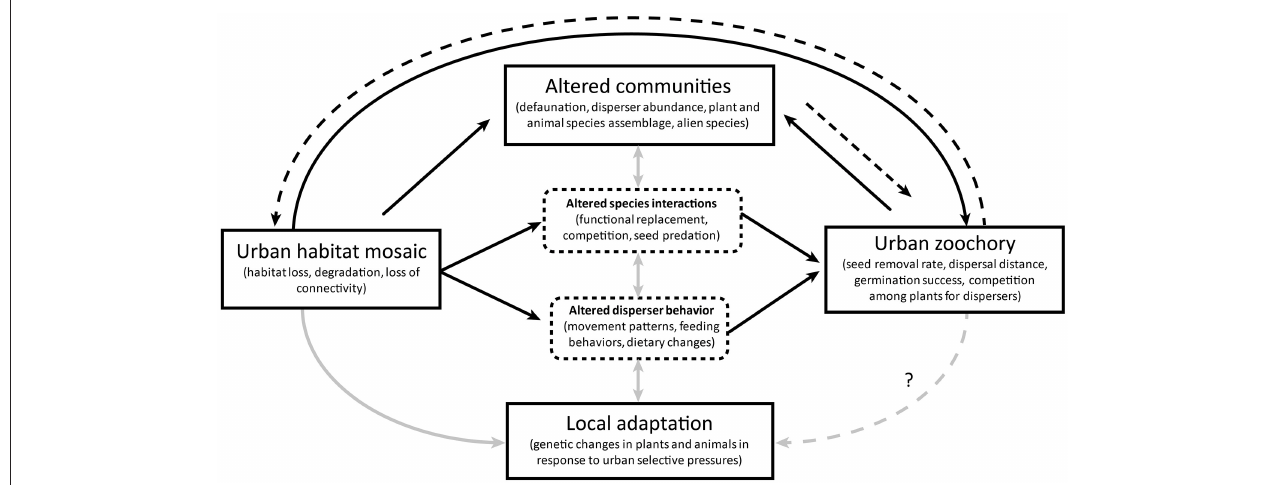
FIGURE 1 | Interdependence between zoochory processes and the urban ecosystems. The urban effects of an altered habitat on zoochory may be direct (e.g., by influencing the abundance of dispersers or their success) or mediated through changes in seed disperser behaviors and novel species interactions (black continuous lines). In turn, seed dispersers shape urban vegetation within the mosaic, strengthening or weakening the processes within the urban habitat (black dashed lines). Complex interactions exist between the urban plant and animal networks, disperser behaviors, and local adaptations of populations in the urban habitat mosaic (gray continuous lines). Zoochory also has the potential to directly influence local adaptations if it acts as a selective pressure. Plant dispersal outcomes and ecosystem dynamics are thus linked to zoochory processes in urban